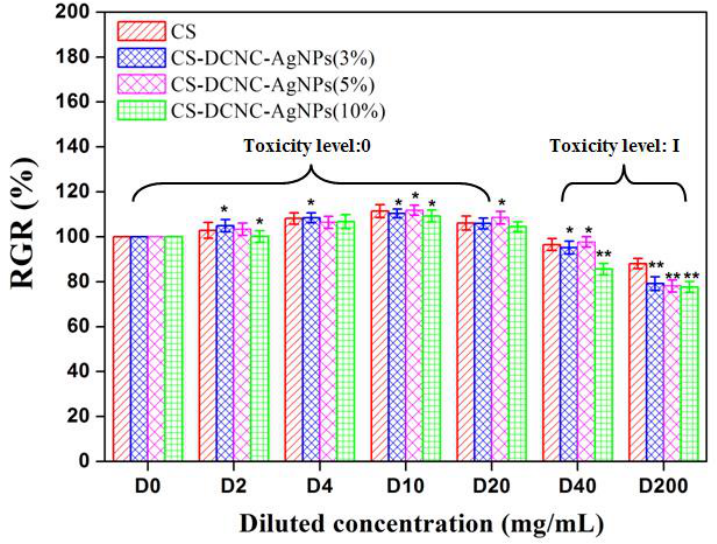
Figure 5. RGR values and cytotoxicity level of CS-DCNC-AgNPs: toxicity level 0 and I represent safe.